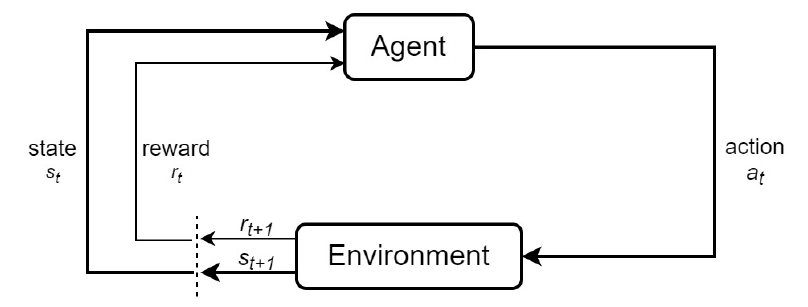
Figure 1. Interaction between the agent and the environment (adapted from